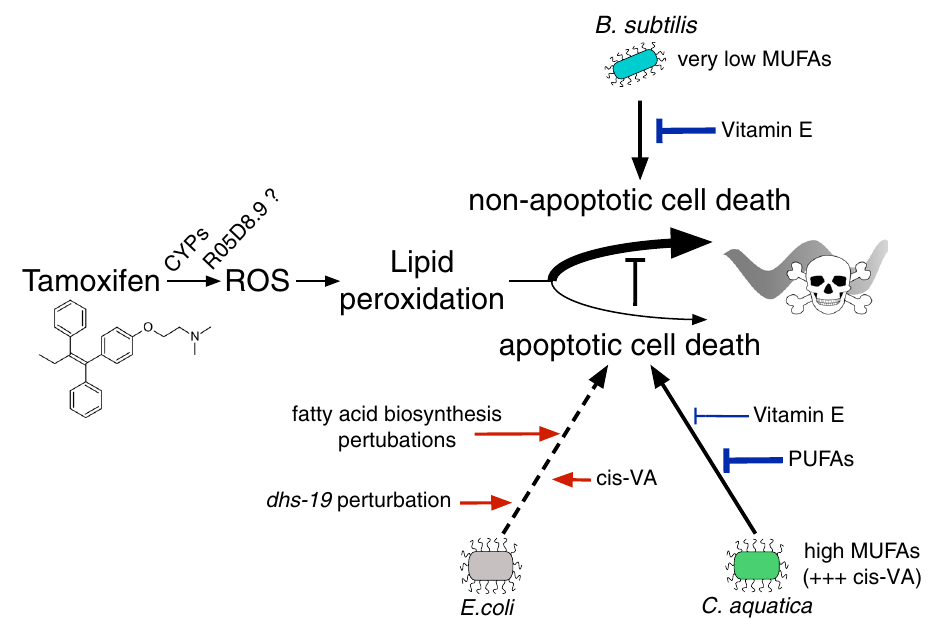
Fig. 7 | Model of the interplay between bacteria, fatty acid metabolism, and death pathways affecting tamoxifen toxicity. C. elegans detoxifying enzymes such as cytochrome P450 ( CYPs ) and potentially R05D8.9 , metabolize tamoxifen thereby producing signi fi cant amounts ofreactive oxygen species (ROS).The lipid oxidative stress caused by these ROS leads to varying levels of tamoxifen toxicity dependingonthebacterialdietoftheanimals.Thefattyacid(FA)compositionof E. coli , C. aquatica , and B. subtilis displays extensive differences and de fi nes the